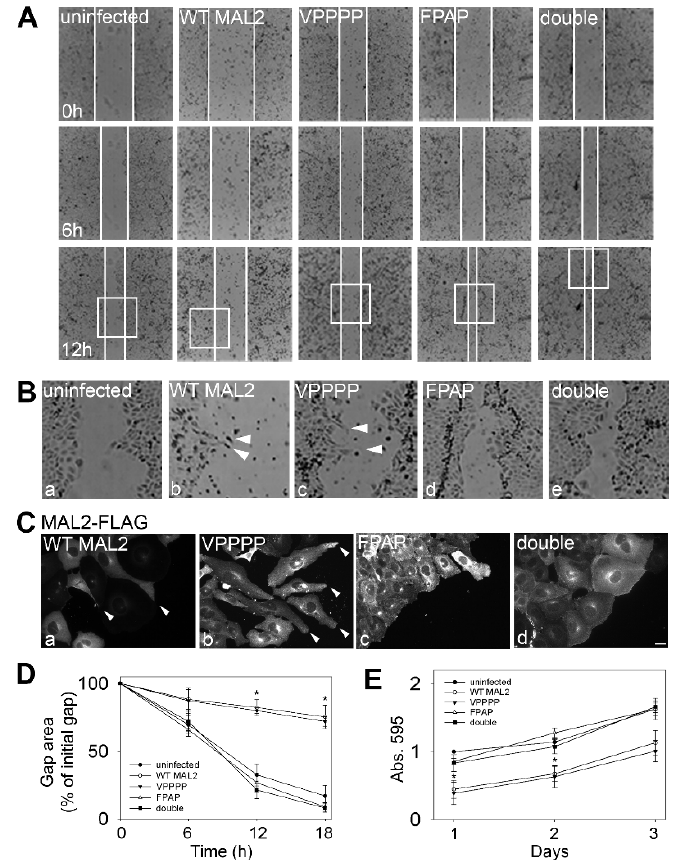
Figure 9. The FPAP motif mediates MAL2-induced protrusion formation and impaired cell migration. ( A ) Monolayers of infected cells or cells expressing wild type (WT) or mutant MAL2 as indicated were scratched and wound healing was imaged 0 h (upper panels), 6 h (middle panels) and 12 h (lower panels) post-scratch. White lines indicate the edges of the gap. ( B ) The boxed areas in Part A were enlarged. Arrowheads in panels c and d indicate protrusions in cells expressing wild type or the VPPPP mutant MAL2 at the migrating edge. ( C ) Cells at the migrating edge were immunolabeled for MAL2 (with anti-FLAG antibodies). The Arrowheads in panels a and b indicate protrusions in cells expressing wild type or the VPPPP mutant MAL2 at the migrating edge. Bar = 10 µm. ( D ) The gap area remaining after 0, 6, 12 ( p ≤ 0.008 for WT and ≤ 0.005 for VPPPP) and 18 h ( p ≤ 0.008 for WT and ≤ 0.005 for VPPPP) of recovery was determined relative to the area of the initial gap in cells expressing wild type and mutant MAL2 as indicated. Values represent the mean ± SEM from at least five independent experiments. ( E ) Uninfected or MAL2-expressing cells were seeded onto 96-well plates at 4000 cells / well and relative cell numbers monitored after 1 ( p ≤ 0.006 for WT and ≤ 0.01 for VPPPP), 2 ( p ≤ 0.008 for WT and ≤ 0.024 for VPPPP) or 3 days. Values represent the mean ± SEM from at least three independent experiments each performed in triplicate.